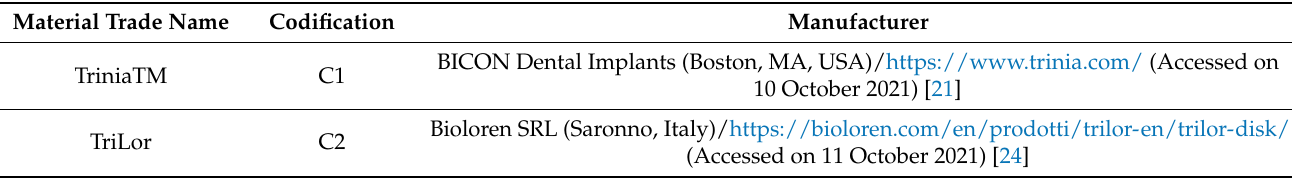
Table 1. Name, sample codification, and manufacturer of materials